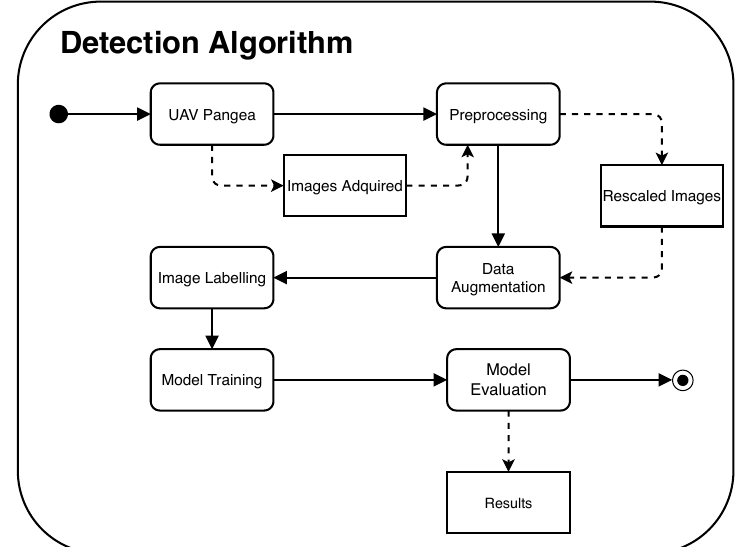
Figure 4. Block diagram of the drone detection